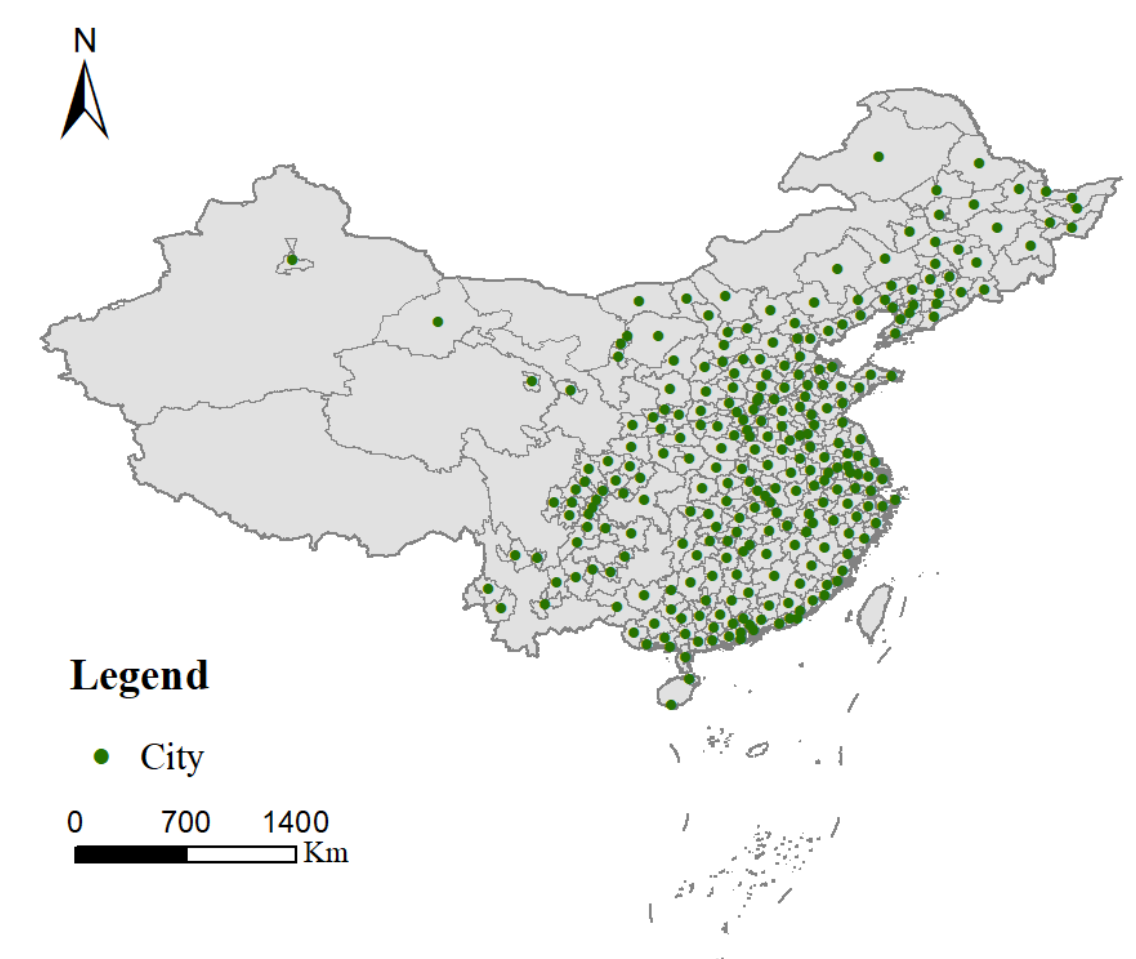
Figure 2. The locations of 266 prefecture-level cities in China.